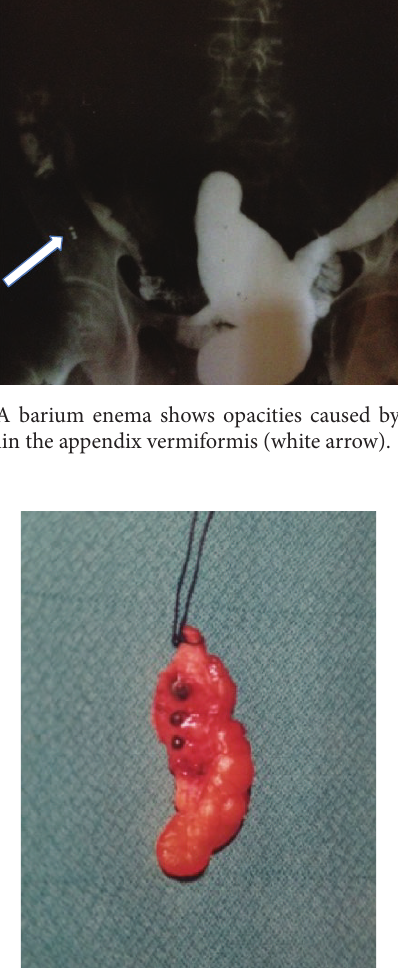
discharged on postoperative day 2 without